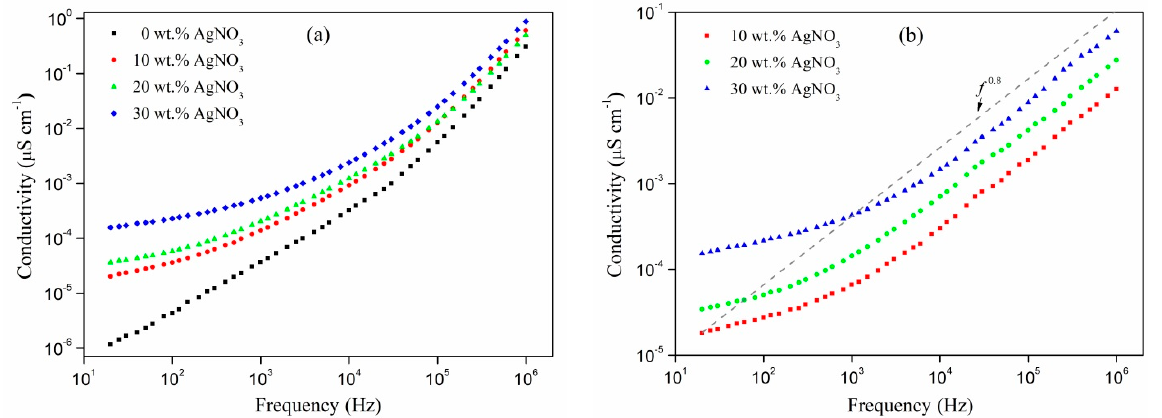
Figure 6. Conductivity vs. AC frequency plot for Ag/PAN nanocomposites prepared at various concentrations of silver nitrate in a starting mixture ( T = 10 °C, PI concentration is 15 wt.%) with the account of the polymer conductivity ( a ) and without the account of the polymer conductivity ( b ). The dotted line shows the dependence of f 0.8 for an arbitrary value of the coefficient A .